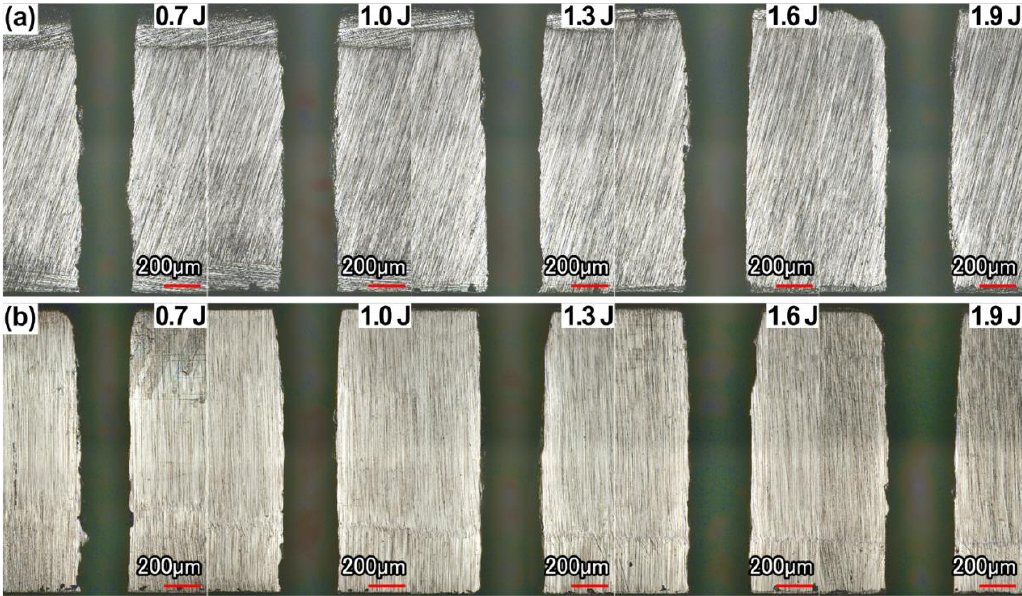
Micromachines 2022 , 13 , 2249